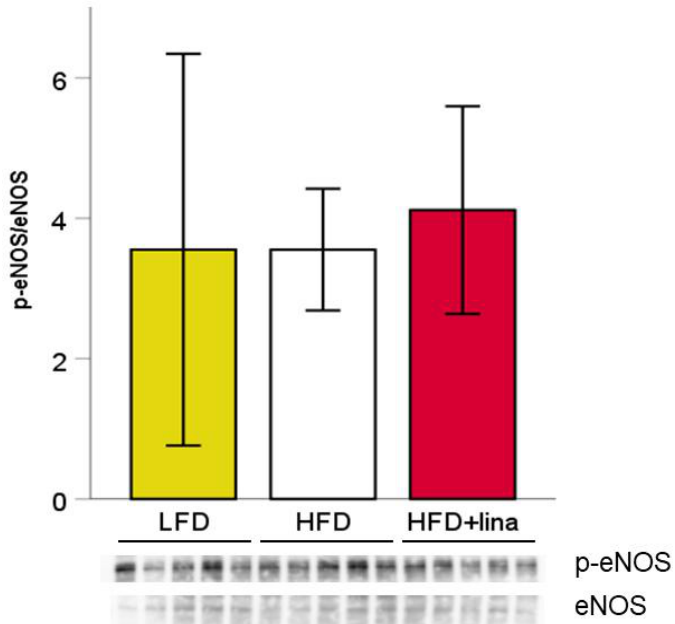
Figure 6. E ff ects of linagliptin (10 mg / kg BW / day) on tau phosphorylation in PS19 mice at 8 months of Figure 6. Effects of linagliptin (10 mg/kg BW/day) on tau phosphorylation in PS19 mice at 8 months age. Linagliptin did not significantly a ff ect the ratio of cerebral phosphorylated eNOS / eNOS. Values of age. Linagliptin did not significantly affect the ratio of cerebral phosphorylated eNOS/eNOS. are presented as mean ± SD ( n = 5 for each Values are presented as mean ± SD ( n = 5 for each group).